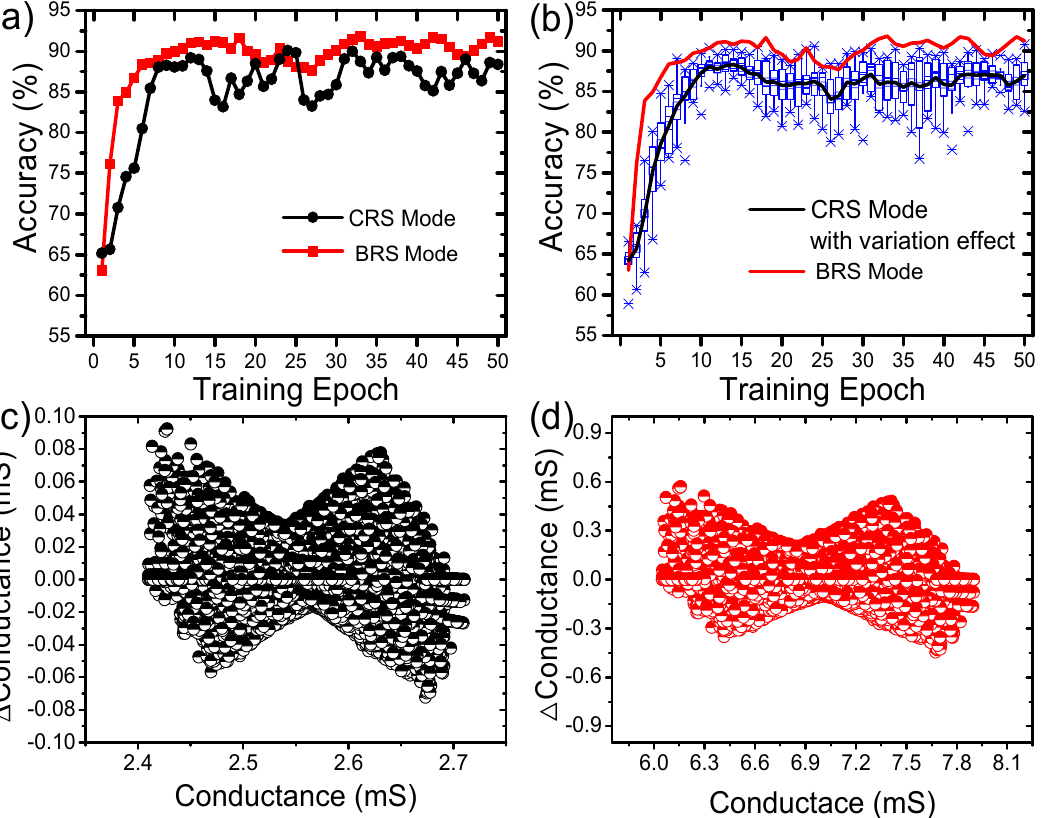
Figure 5. Neuromorphic system depending on the switching mode: recognition accuracy ( a ) without and ( b ) with considering the variation of the learning property; distribution of weight for ( c ) the CRS mode and ( d ) the BRS mode.